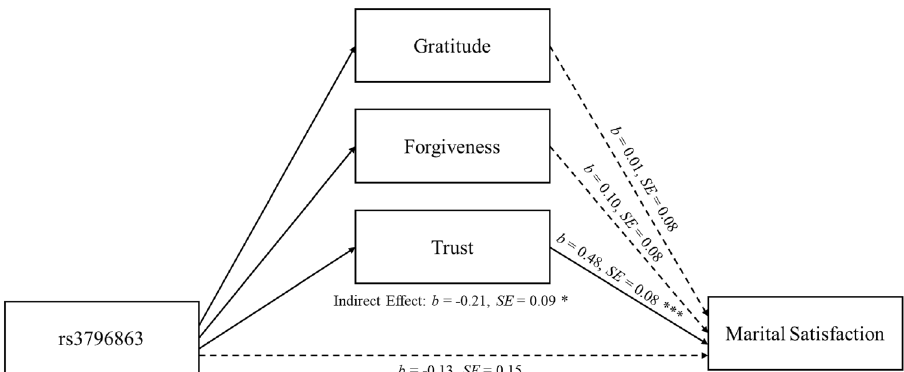
Figure 1. Path b coefficients from the mediation model are shown. Marital satisfaction, gratitude, trust, and forgiveness were standardized. Path a coefficients for the associations between rs3796863 and gratitude, trust, and forgiveness are reported in Table 1. Trust significantly mediated the association between rs3796863 and marital satisfaction. * p < 0.05 *** p < 0.001.